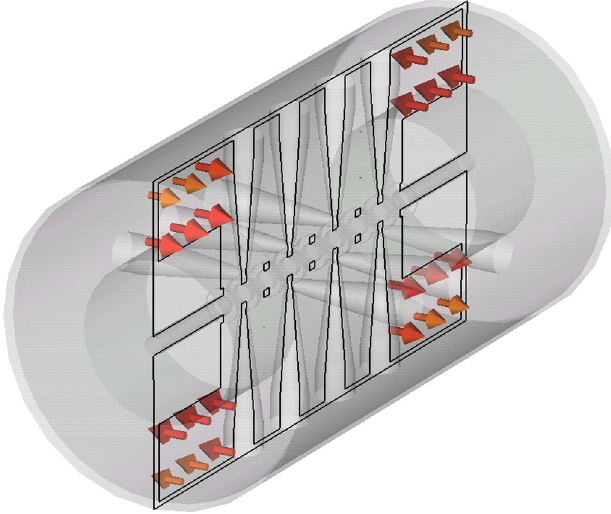
FIG. 24. The magnetic field distribution in the middle plane of the coupling cell, projection B - B 0 of Fig.